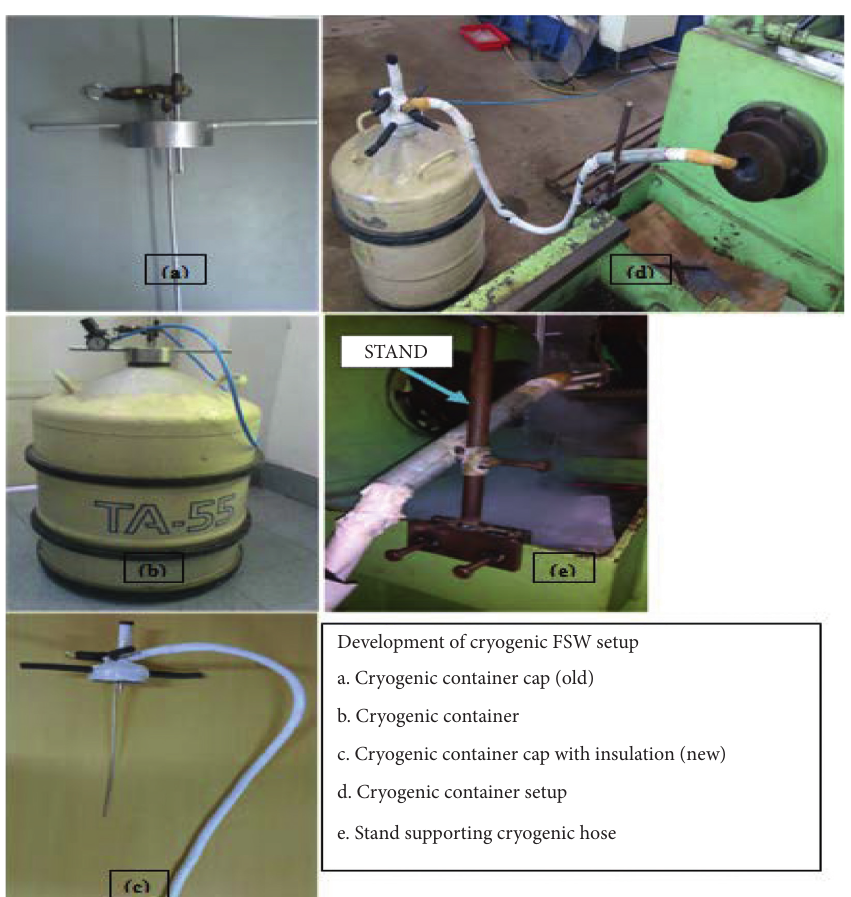
Figure 4: Images of the setup.